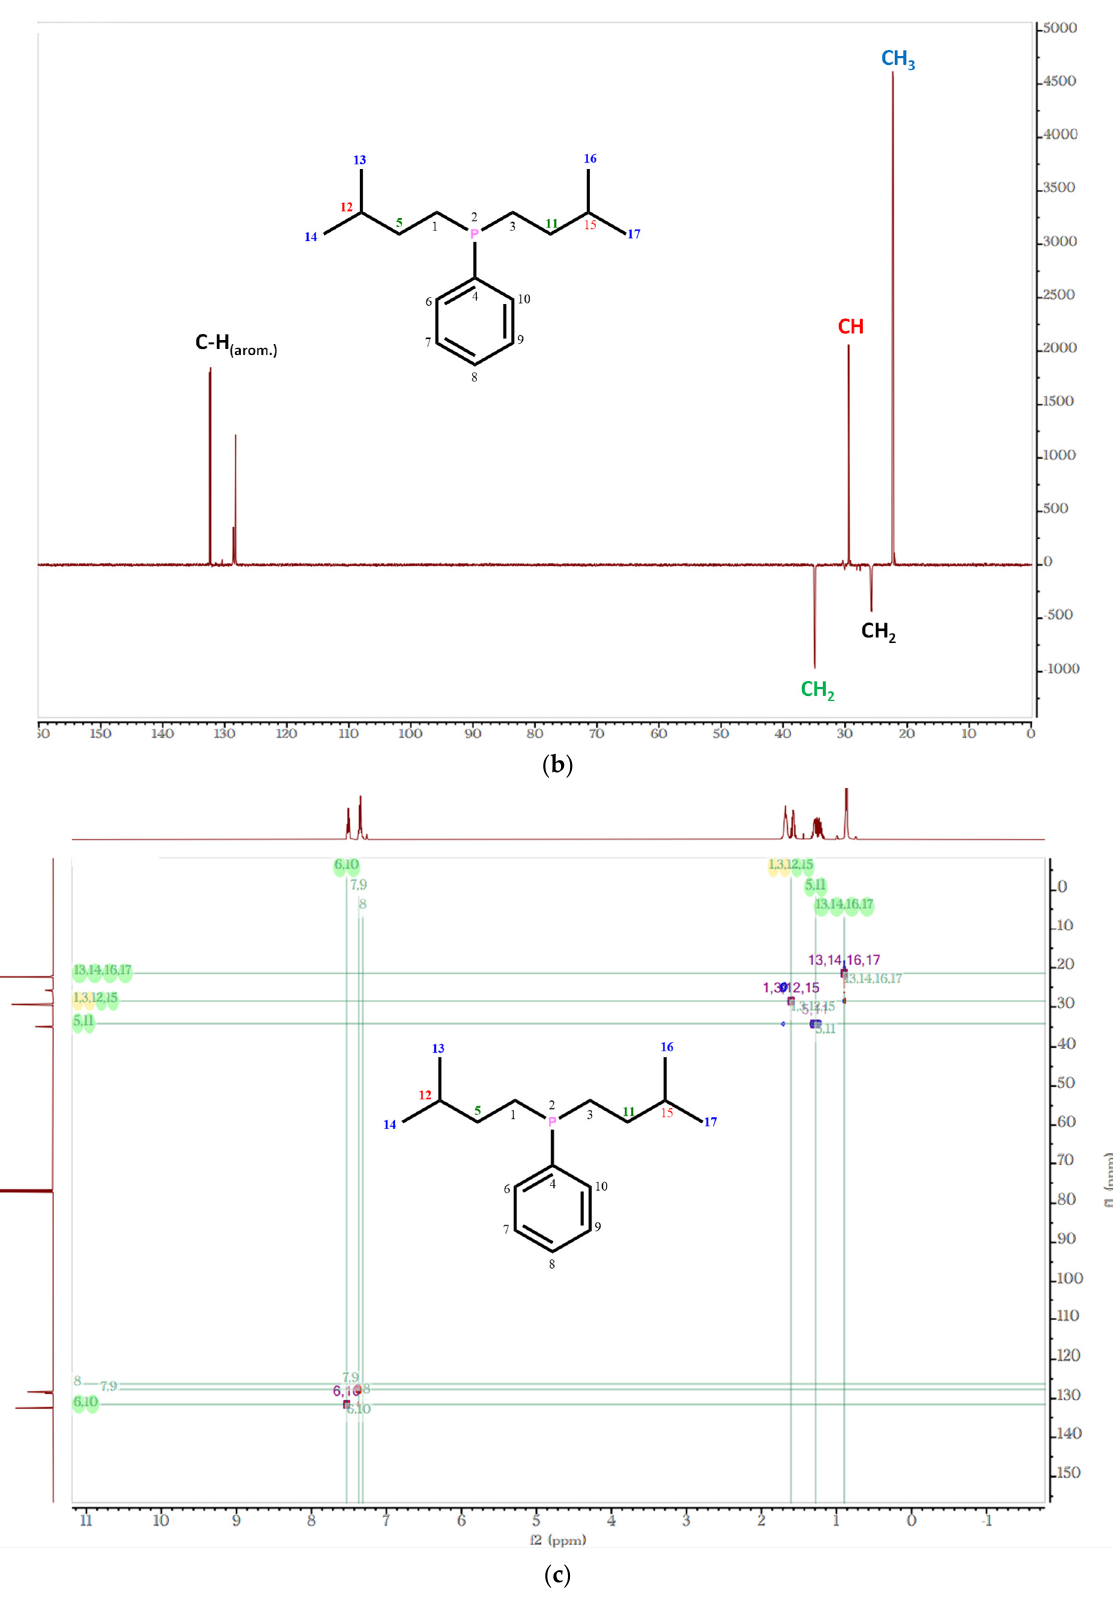
Figure 4. 1 H- 1 H COSY ( a ), DEPT-135 ( b ), and 1 H- 13 C HSQC-COSY ( c ) spectra of compound ( 10 ). Figure 5 depicts the IR spectra of compound ( 10 ) and a commercially available tributylphosphine (PBu 3 ). Due to their structural similarity, the IR spectra were found to